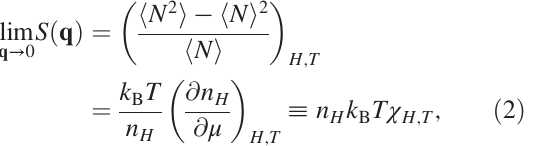
; α Þ for the dense FIG. 6. Azimuthal structure factor S ð q max ¼ 0 . 75 σ − 3 ; green and blue lines) and moderately dense ( n b ¼ 0 . 38 σ − 3 ; magenta and red lines) confined hard-sphere ( n b fluid. The data are presented at a fixed scattering vector magnitude q of the primary peak (red arrows in Figs. 4 max and 5), as a function of the azimuthal angle α ¼ arctan ð q ⊥ =q ∥ Þ on a circle of radius q in Figs. 4 and 5. For the top two cases, max ¼ 1 . 03 , and for the bottom two, 0.97. The solid and dashed q max black lines depict corresponding APY data assuming hard ( βϵ ¼ 0 ) and slightly sticky hard walls ( βϵ ¼ 1 . 1 .), respectively. The data are vertically offset by multiples of 1.0 for clarity in the top three